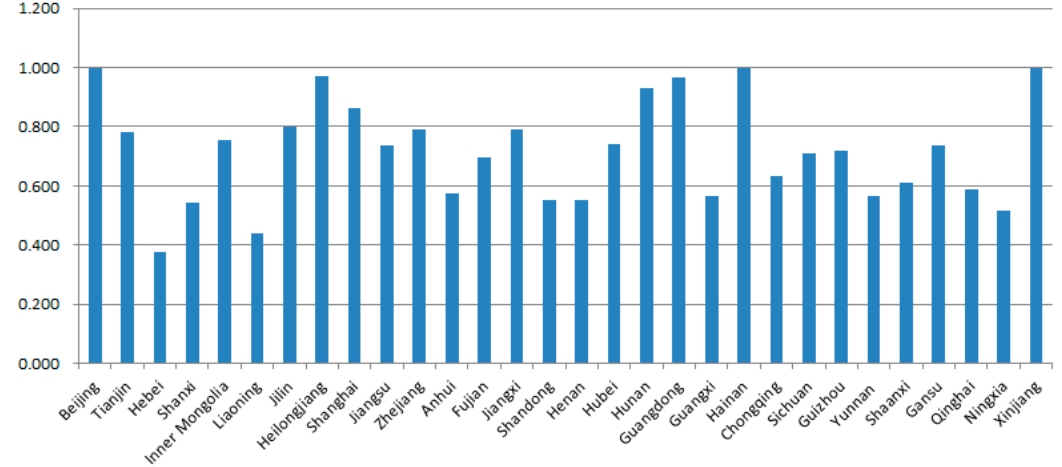
ffi ciency under managerial disposability and constant Figure 4. Average environmental efficiency under managerial disposability and constant DTS. Figure 4. Average environmental e